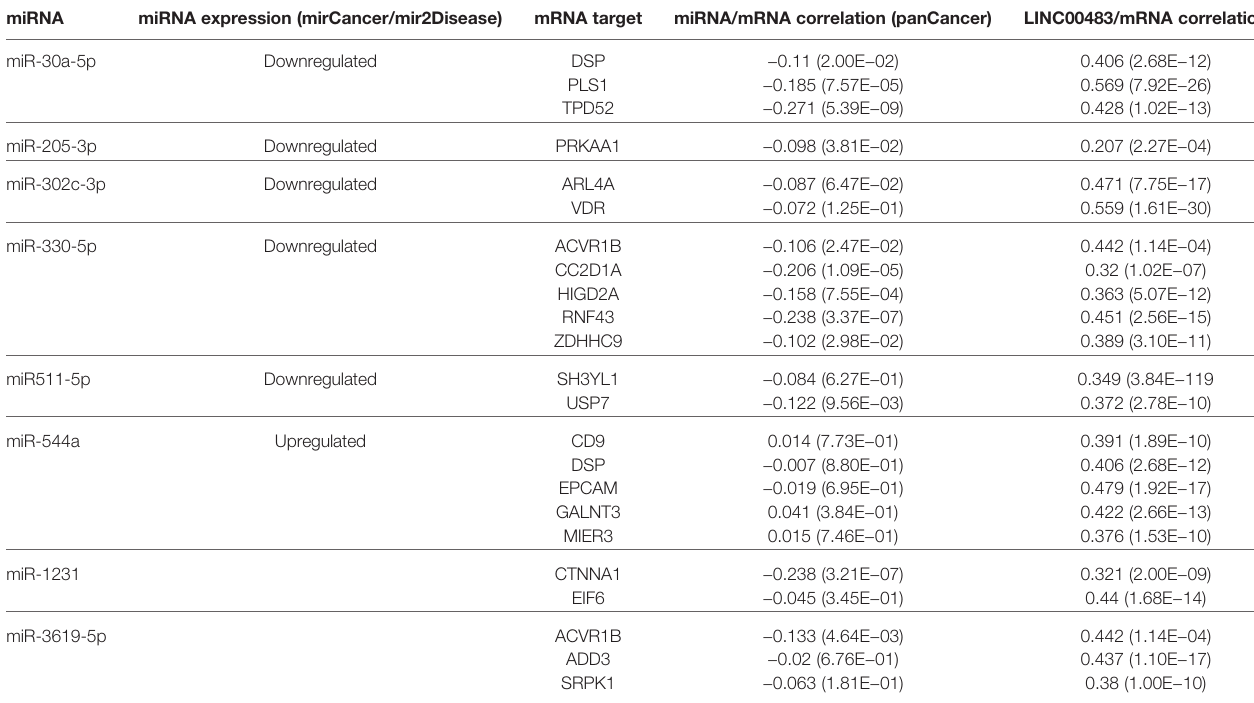
TABLE 4 | Predicted LINC00483 molecular axes in colorectal cancer (CRC). miRNA miRNA expression (mirCancer/mir2Disease) mRNA target miRNA/mRNA correlation (panCancer) LINC00483/mRNA correlation miR-30a-5p Downregulated